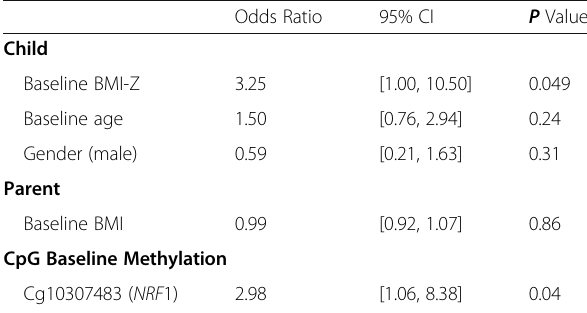
Table 4 Association of baseline differential DNA methylation a with obesity at 36 months, adjusted for